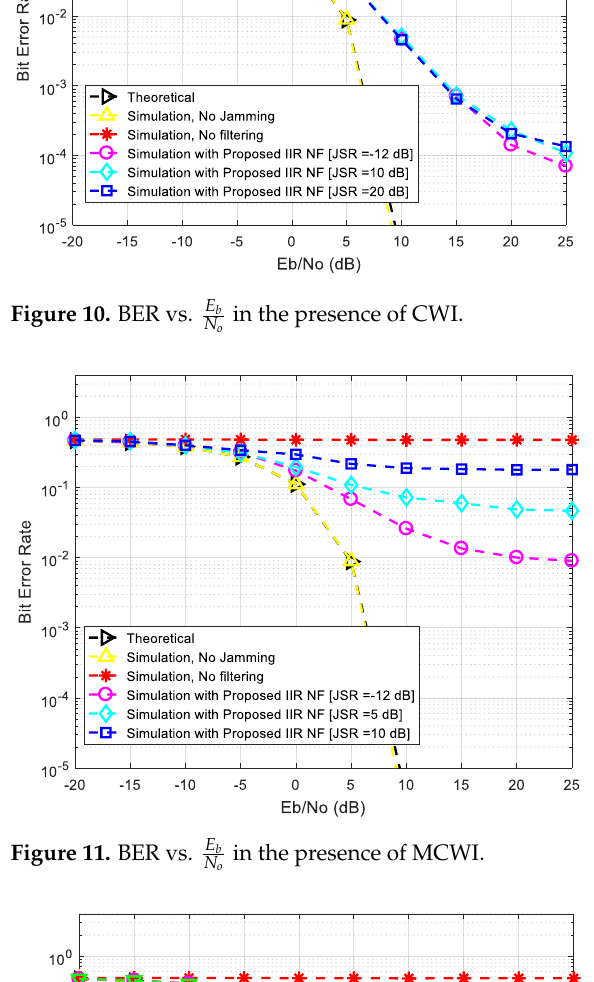
Figure 11. BER vs. Figure 11. BER vs. E b